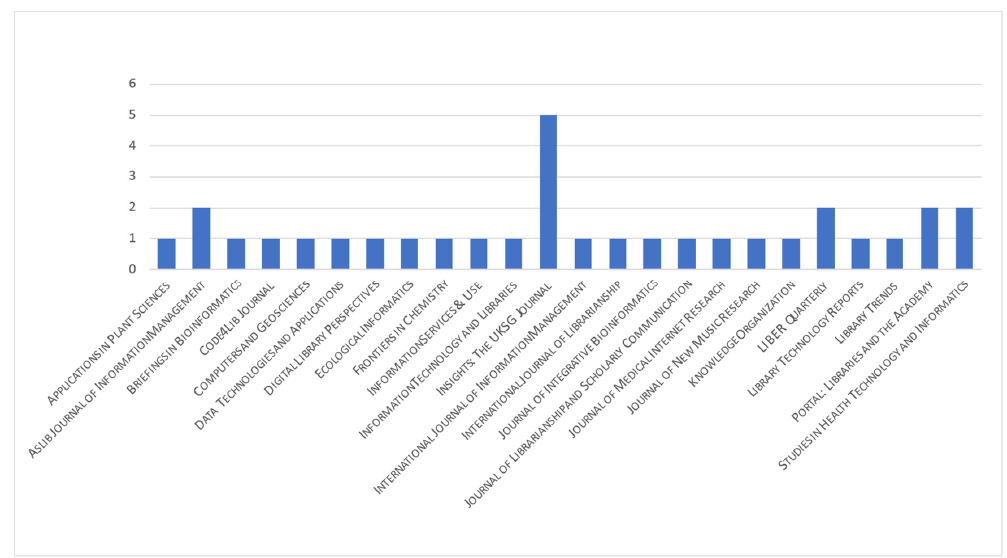
Figure 6. Distribution of Scientific Papers by Journals.